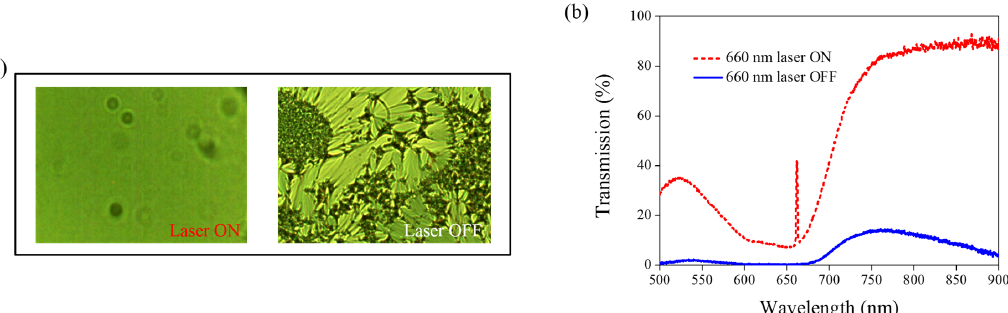
Figure 11. ( a ) POM images (picture area: 270 μ m × 320 μ m) and ( b ) transmission spectra of AQ dye-doped CLC containing A2 molecules (3 wt% AQ dye, 15 wt% A2, 20 wt% S811, and 62 wt% MDA3461) under different conditions of 660-nm wavelength laser exposure. The laser intensity was 100 mW/cm 2 .